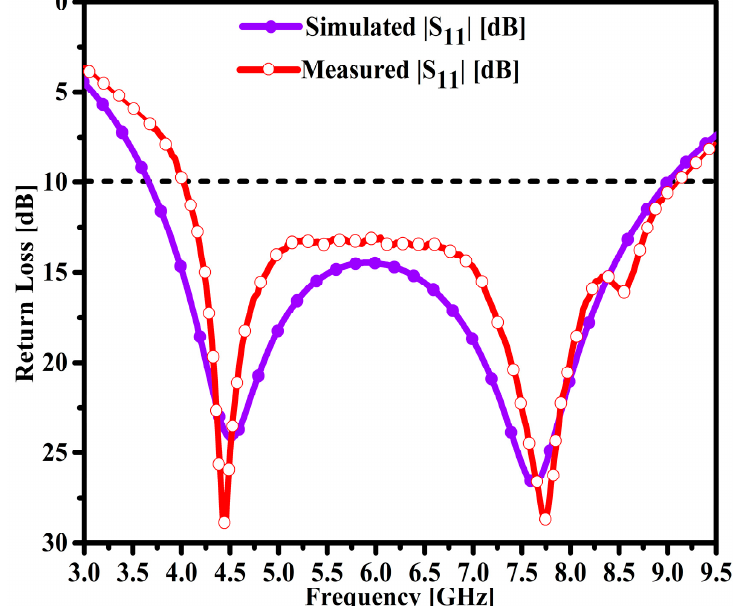
Figure 7. Simulated and tested |S 11 | performance of the proposed antenna.